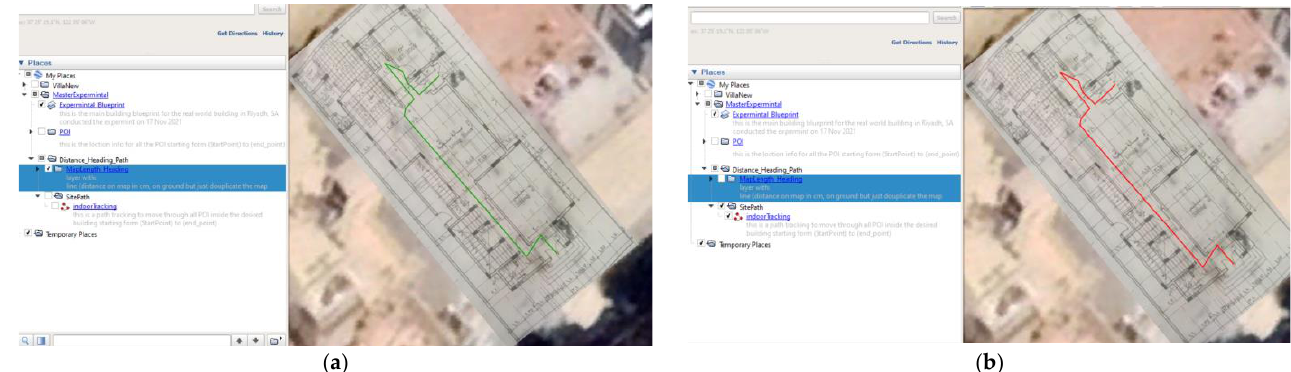
Figure 26. Labeled POIs on the blueprint map.